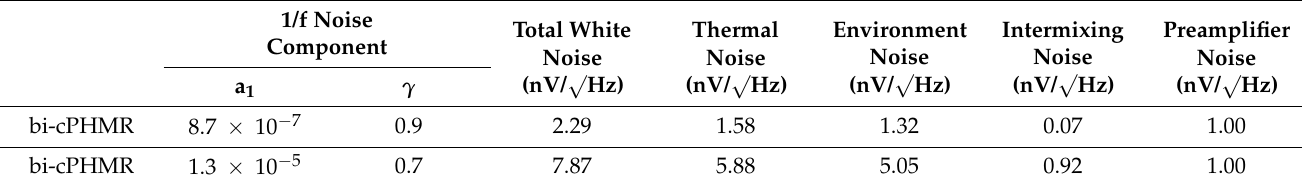
Table 3. Total noise analysis and noise decompositions for bi-layered cPHMR and mPHMR sensors at room temperature. a 0 : white noise component; a 1 /f γ : 1/f noise